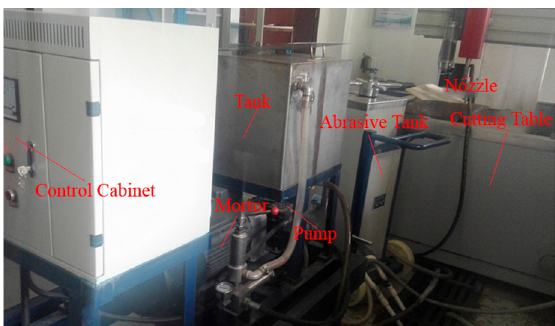
Figure 1. Schematic diagram of abrasive slurry jet (ASJ) generation system.